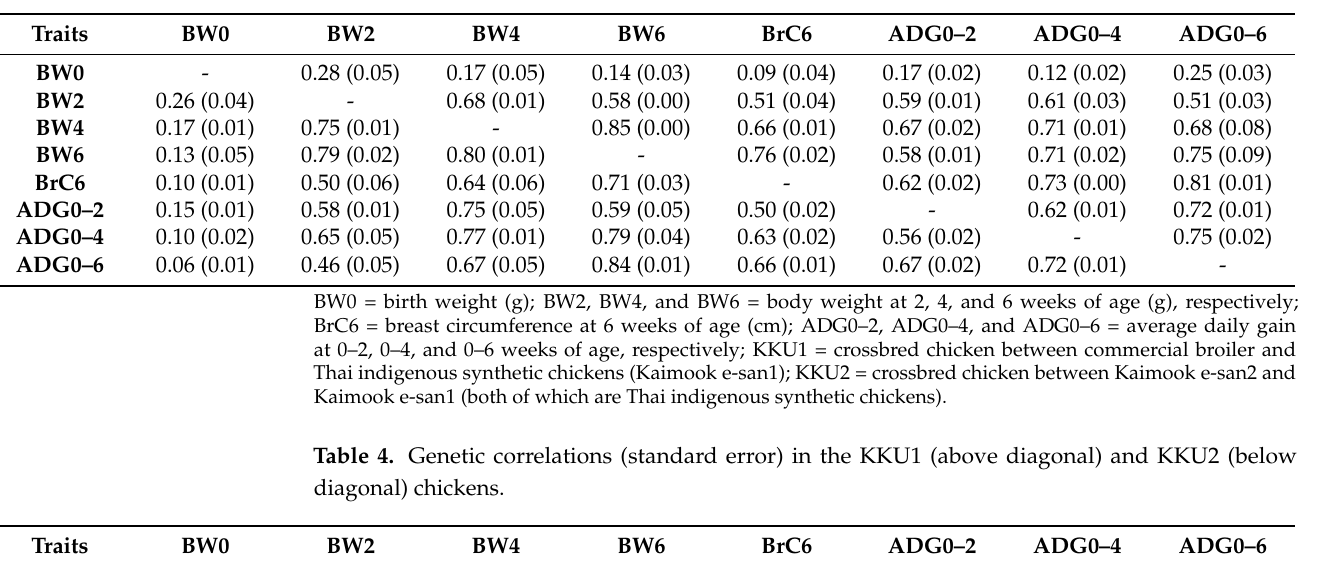
Table 3. Phenotypic correlations (standard error) in the KKU1 (above diagonal) and KKU2 (below diagonal) chickens.